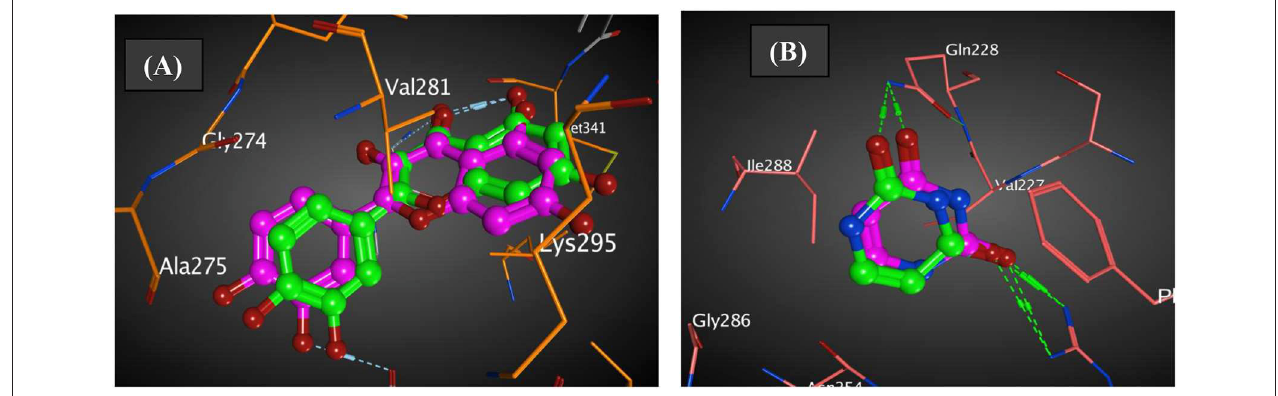
FIGURE 2 | Authentication of docking protocol of (A) 2HCK and (B) 1WS3 (purple compound, co-crystalized ligand; green compound, docked ligand).